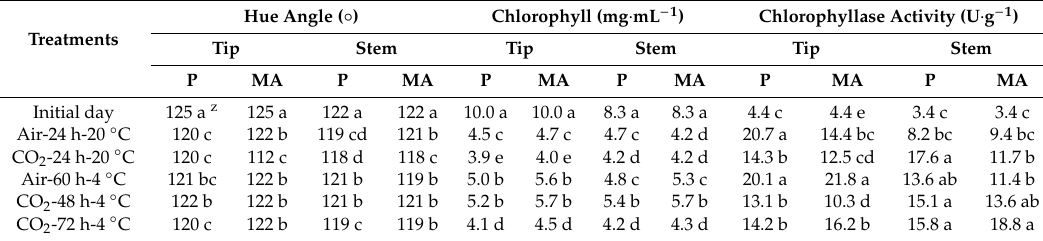
Table 3. Hue angle, chlorophyll content, and chlorophyllase activity of green asparagus in P (the 25th day) and MA (the 30th day)